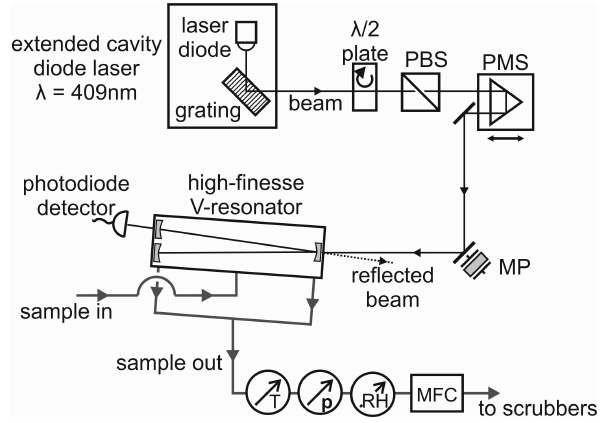
Fig. 6. Schematic diagram of a PeRCEAS NO 2 detector. PBS – po- larizing beamsplitter, PMS – prism with micrometer screw, MP – mirror with piezo, MFC – mass flow controller. The sensors shown measure the temperature ( T ), pressure ( p ) and relative humidity (RH) of the sample gas. The use of the V-resonator allows for op- tical feedback, providing high transmission and obviating the need of an optical isolator between laser and resonator.